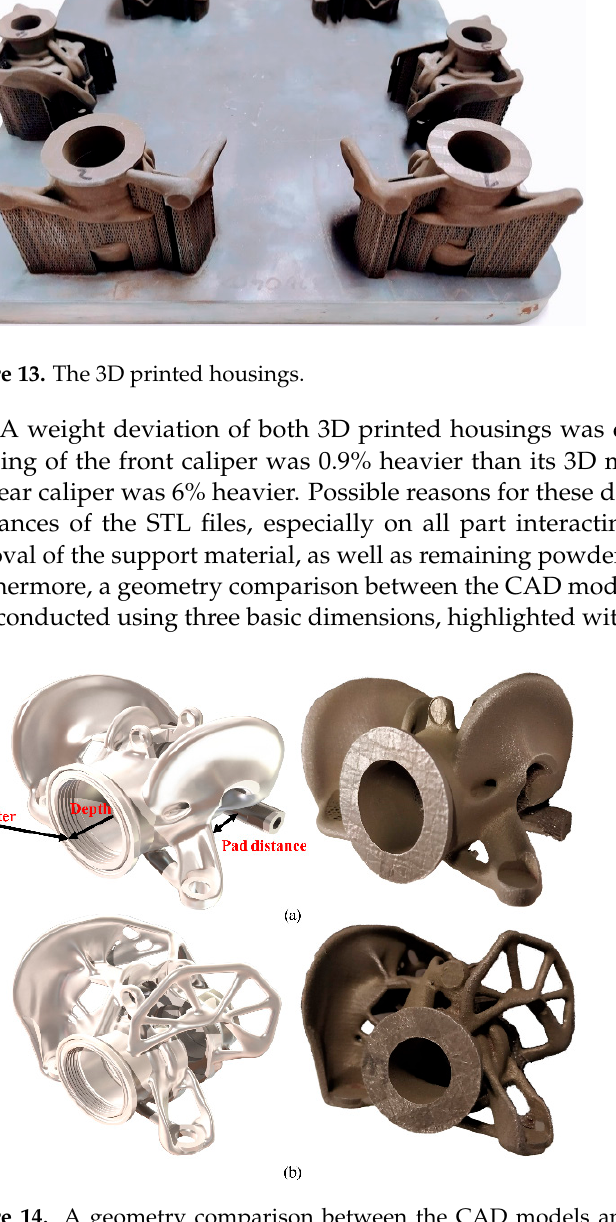
housings: ( a ) The front housing and ( b ) The rear housing.